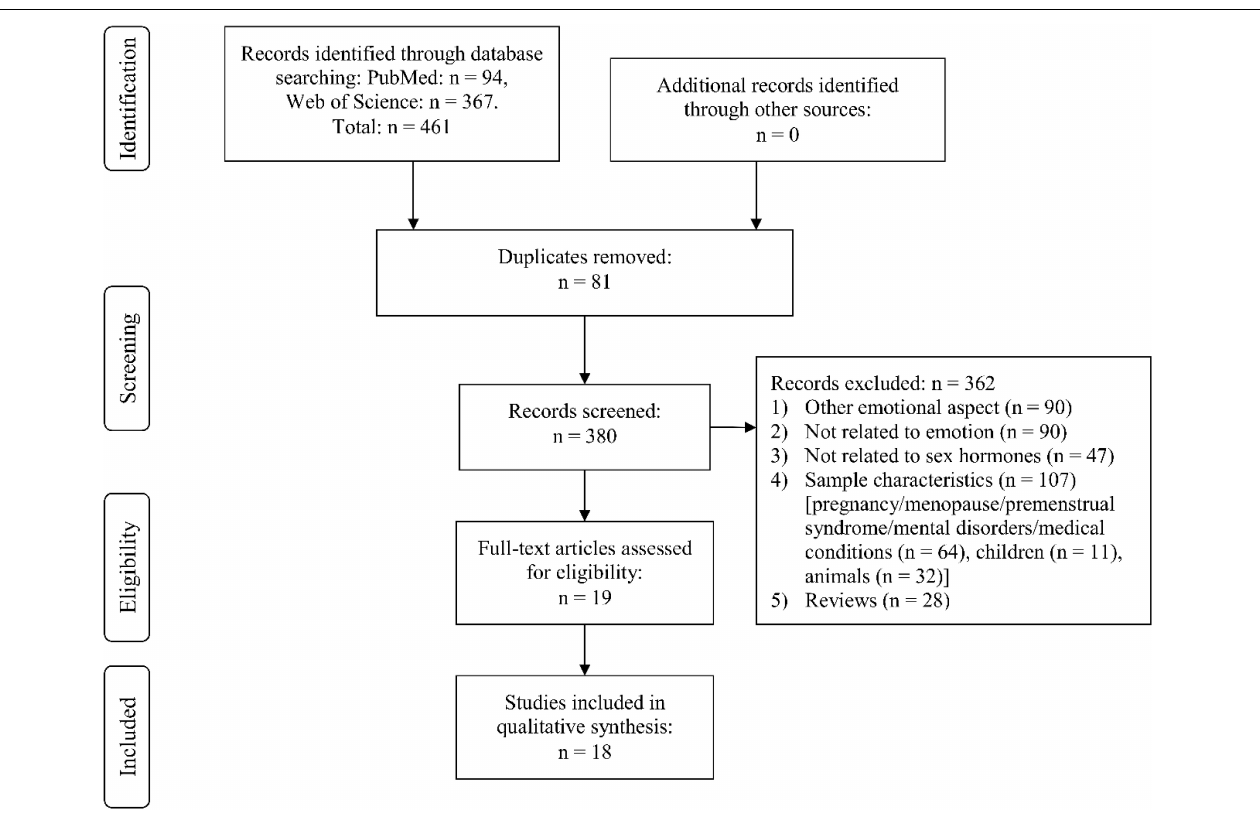
FIGURE 1 | Flow chart showing detailed systematic search and selection process for emotion